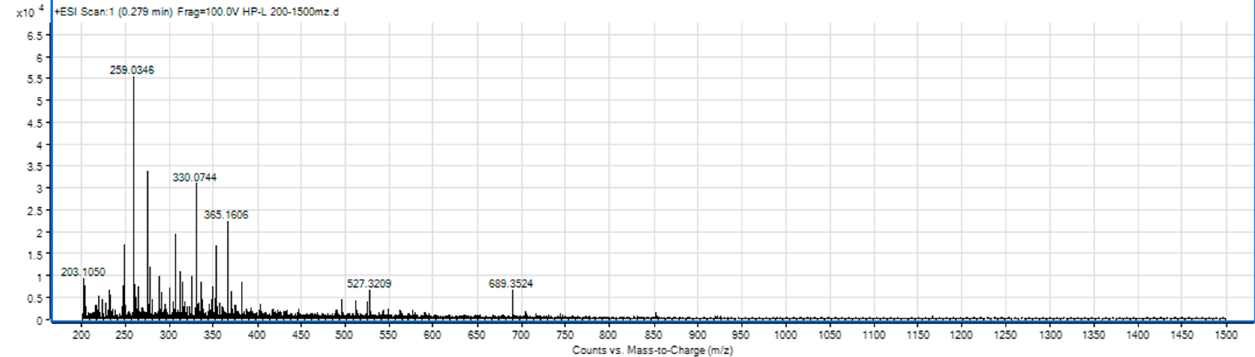
Figure 4. The spectrum of the hydrolysate sample in the domain 200–1500 m / z .